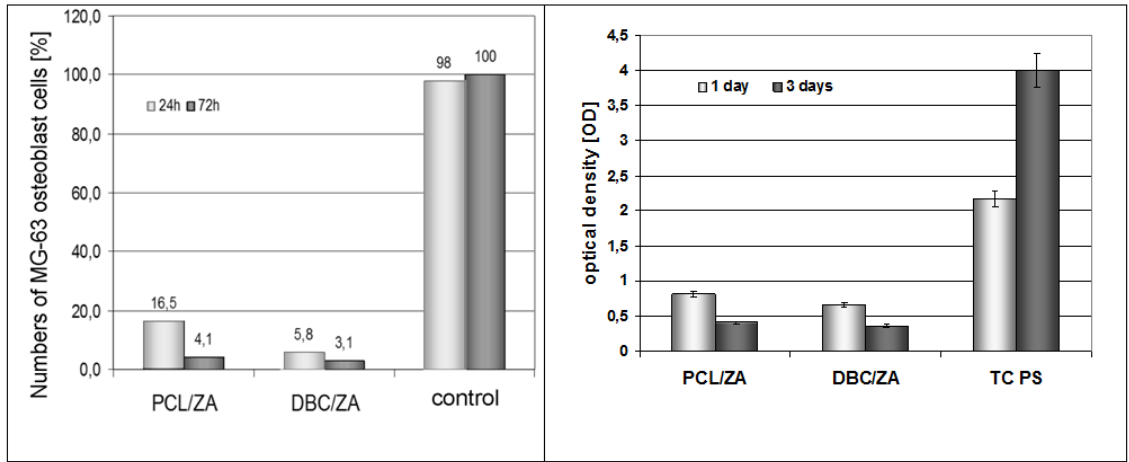
Figure 6. Data showing cell numbers and viability on the surface of composites containing zin alginate fibres.